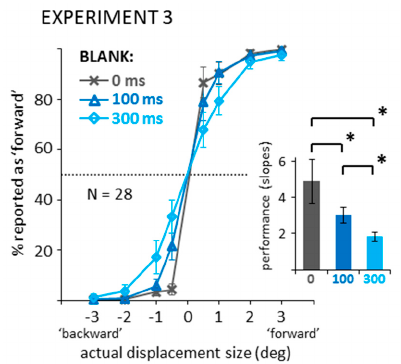
Figure A3. Data recoded into binary displacement direction responses. A: Data from the 0, 100, and 300 ms blank during fixation conditions of Experiment 3. Line graph shows actual displacements (negative: ‘backward’ vs. positive: ‘forward’) against the percentage of reported ‘forward’ responses (dotted line: chance level). Bar graph shows average slopes of the logistic functions fitted to each participant’s individual data. All error bars: between-subjects 95% confidence intervals. Brackets marked with * illustrate significant di ff erences in post-hoc paired-samples t -tests ( p <